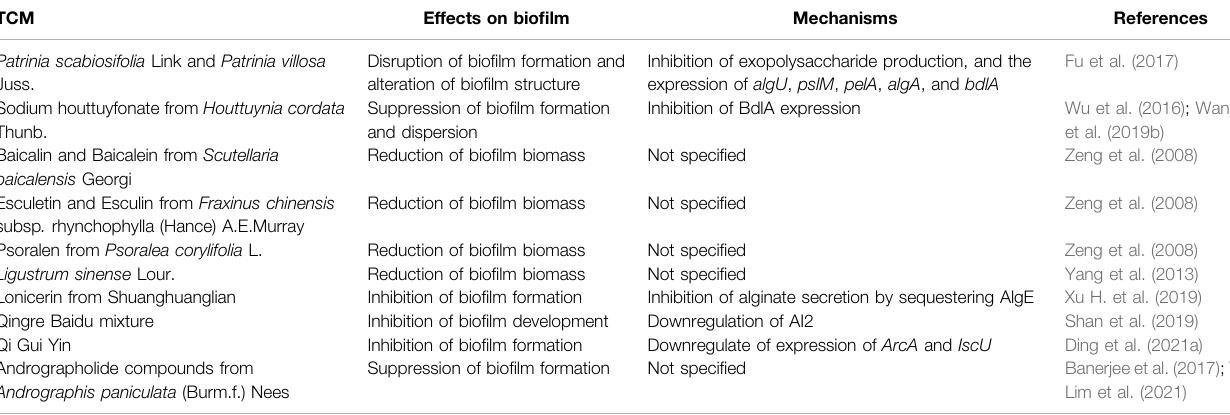
TABLE 3 | Summaries of the TCM for inhibition of P. aeruginosa bio fi